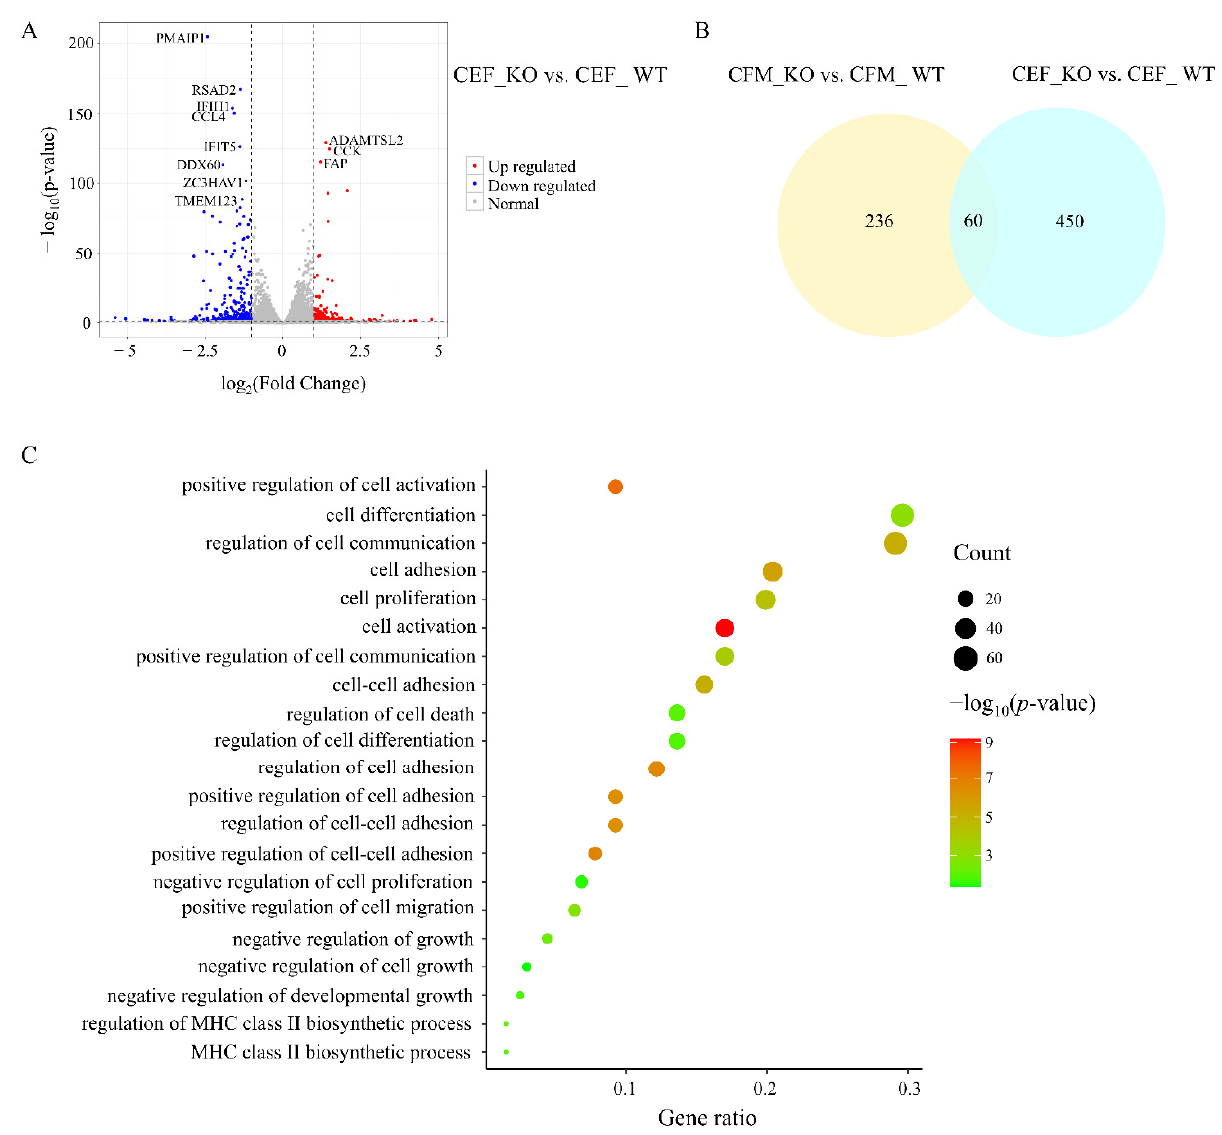
Figure 4. Differential gene analysis and enrichment analysis. ( A ) Volcano plot of significant differen- tially expressed genes (DEGs) of the CEF_KO vs. CEF_WT comparison. ( B ) A Venn diagram showing the DEGs identified from the CFM_KO vs. CFM_WT and the CEF_KO vs. CEF_WT comparisons. ( C ) The pathways were enriched only in CFM_KO vs. CFM_WT, but not in CEF_KO vs. CEF_WT.